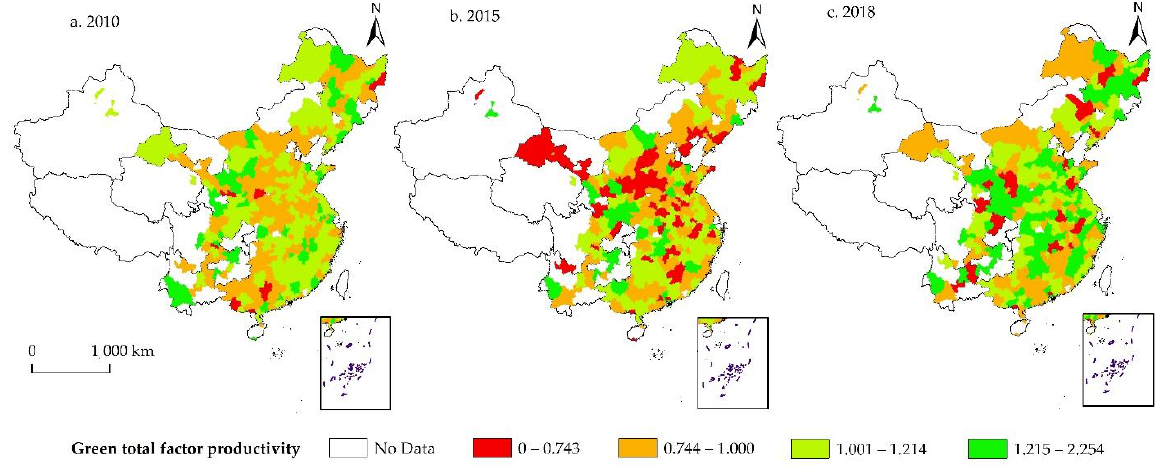
Figure 1. Spatial-temporal pattern of GTFP in China during 2010 – 2018.